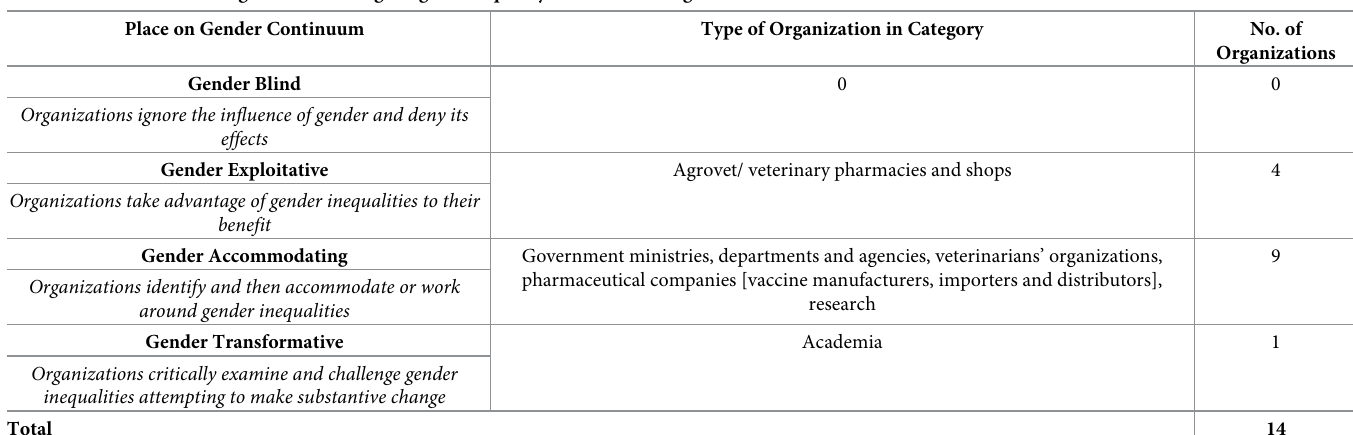
Table 3. Classification of organizations along the gender equality continuum using the GECT.